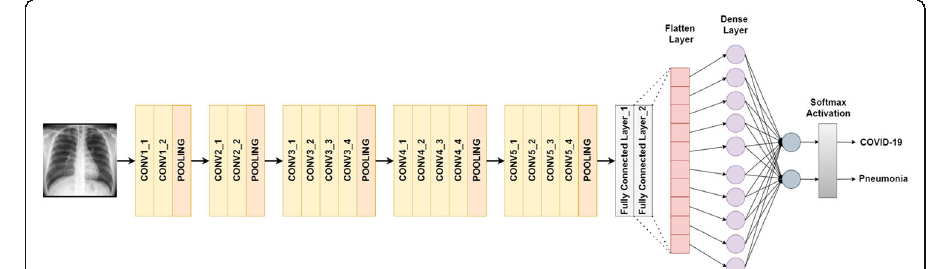
Fig. 2 VGG19 architecture designed for binary classification